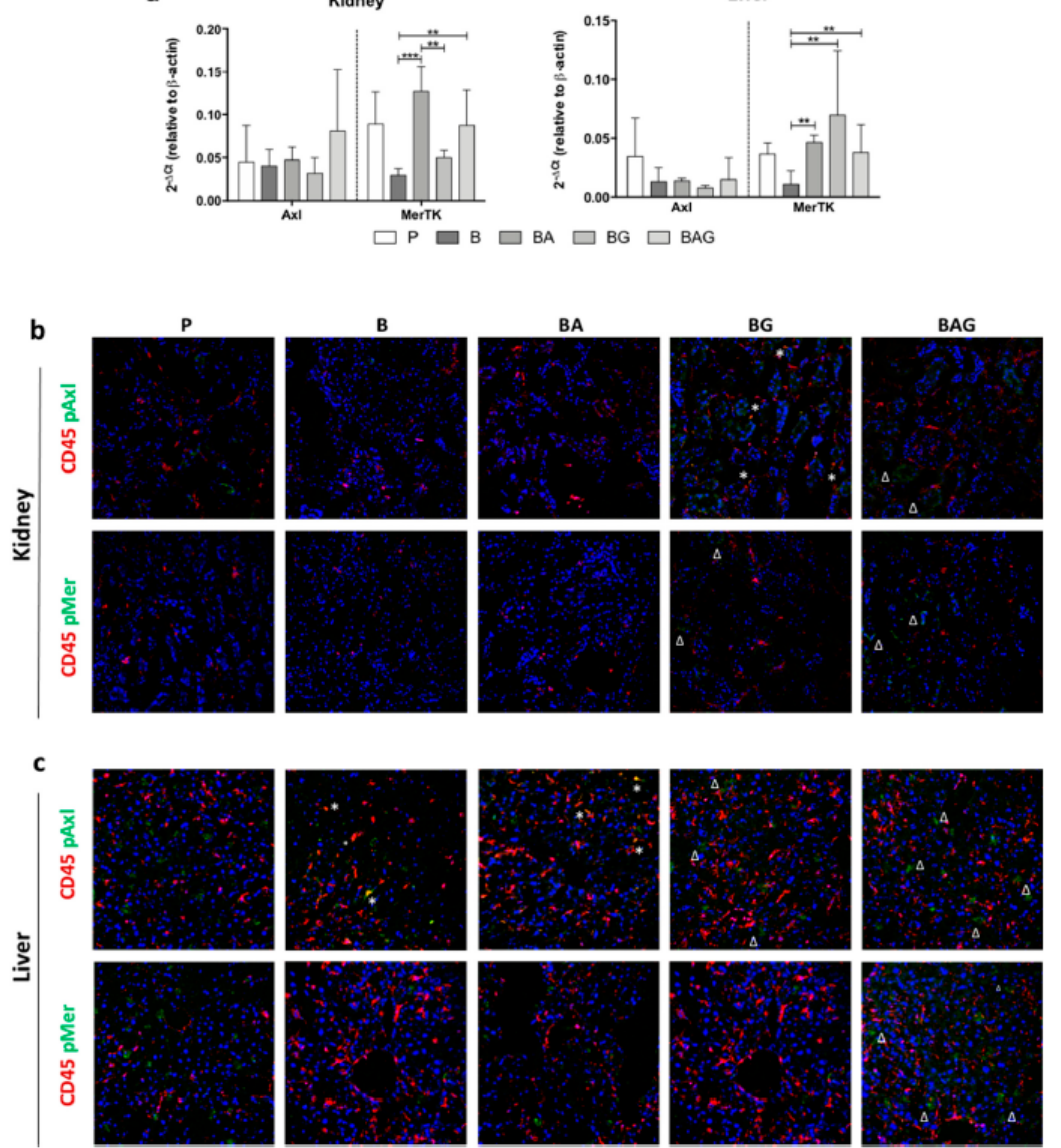
Figure 4. MerTK and Axl expression and activation in the liver and kidney. ( a ) MerTK and Axl mRNA expression levels in the kidney (upper panel) and liver (lower panel) of mice from the treatment groups described in the legend to Figure 1 (i.e., P, B, BA, BG and BAG). The bar graphs represent mean ± SD. ** p < 0.01, *** p < 0.005. Immunofluorescence on kidney ( b ) and liver ( c ) sections showing protein expression of CD45 (red) and phospho-Axl (pAxl) or phospho-MerTK (pMer) (green). The white asterisks (*) indicate pMer/pAxl and CD45 co-staining, whereas the white deltas ( ∆ ) indicates pAxl/pMer localized in CD45-negative cells. For all analysis septic mice (B = bacteria, septic mice n = 4), septic-treated mice (BA = bacteria + ampicillin, n = 4; BG = bacteria + Gas6, n = 4; BAG = bacteria + ampicillin + Gas6, n = 5) and control mice ( p = PBS, n = 4) were